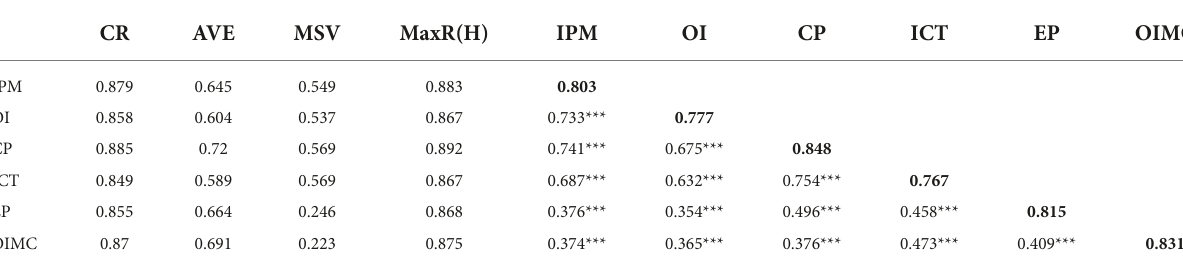
TABLE 2 Reliability, validity statics, and